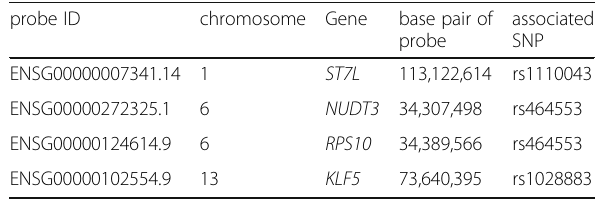
Table 4 SMR of GTEx eQTLs and lean mass GWAS, results for skeletal muscles